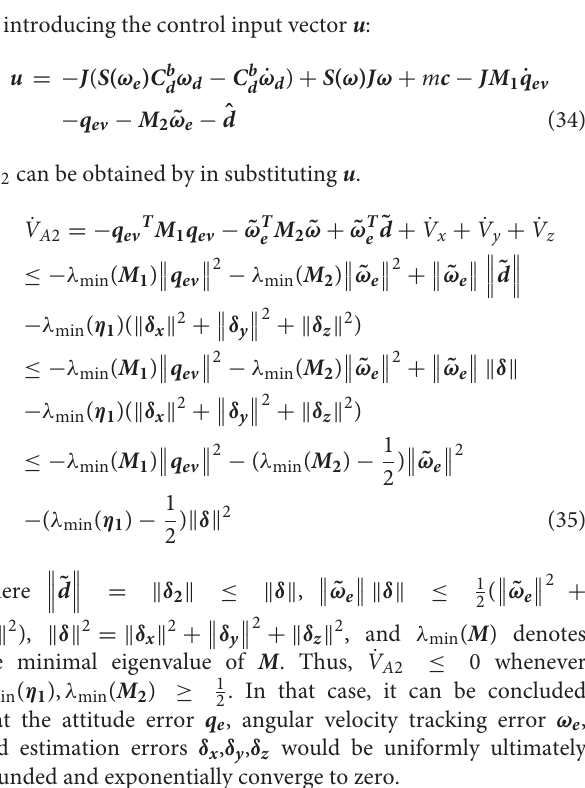
Figure 4 . The meanings of different combinations of coefficient values are listed in Table 1